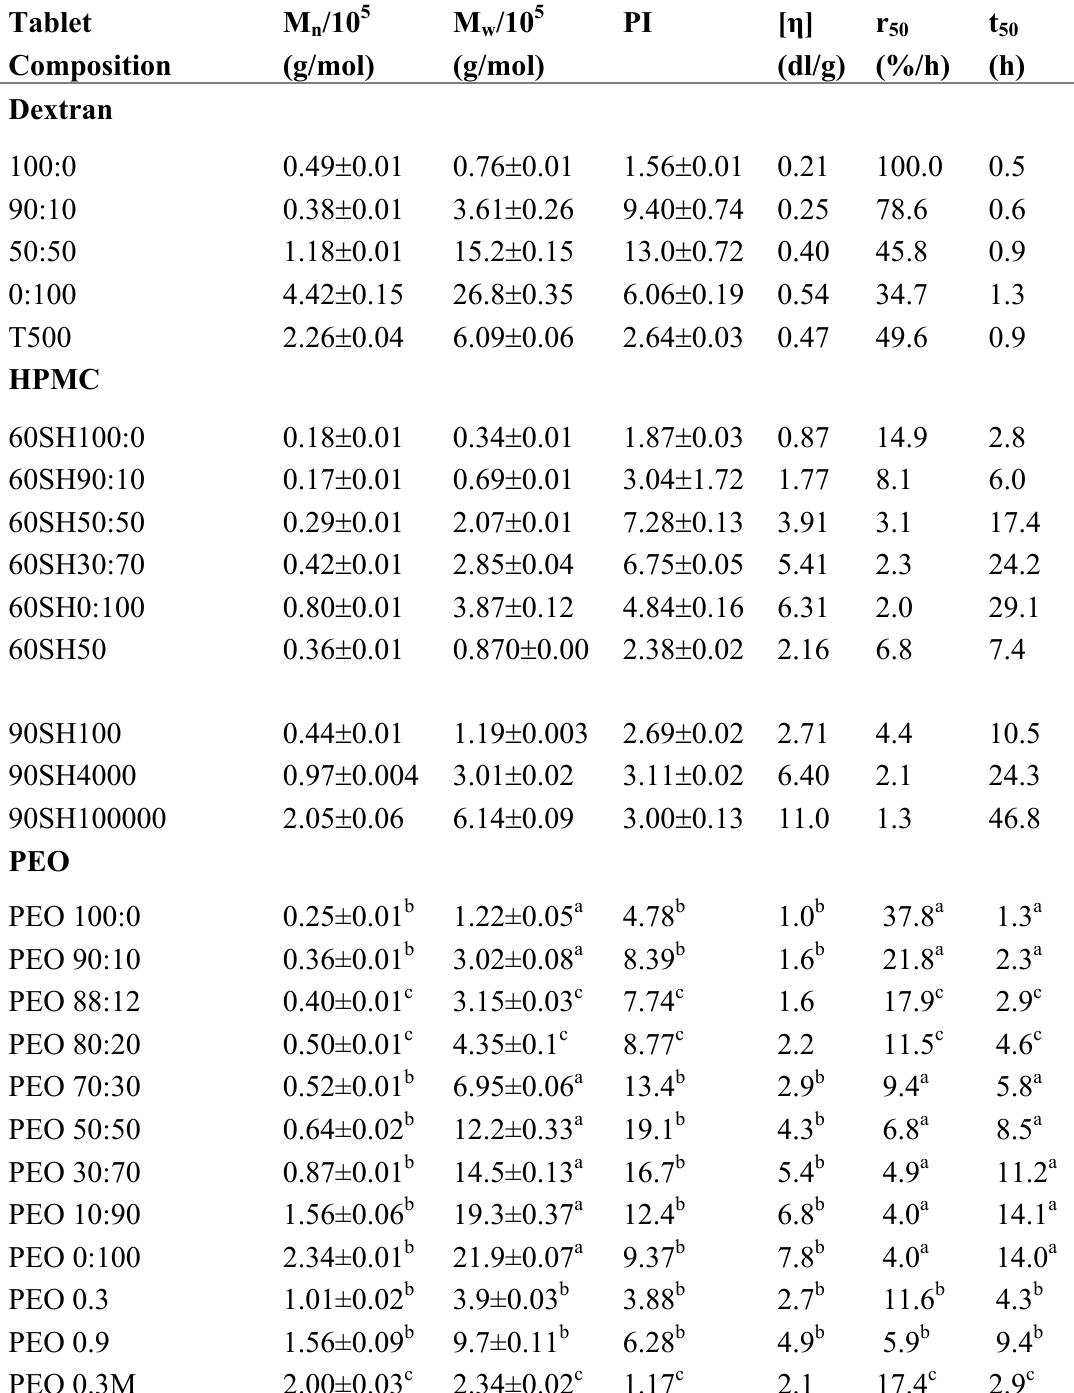
Table 1. Characteristics of the tablet compositions used in this study. The average ± one standard deviation (n=3) is given for the number average molecular weight, Mn, the weight average molecular weight Mw, the average intrinsic viscosity [ η ] and polydispersity index, and time when 50% was released t PI, together with the release rate r 50 50